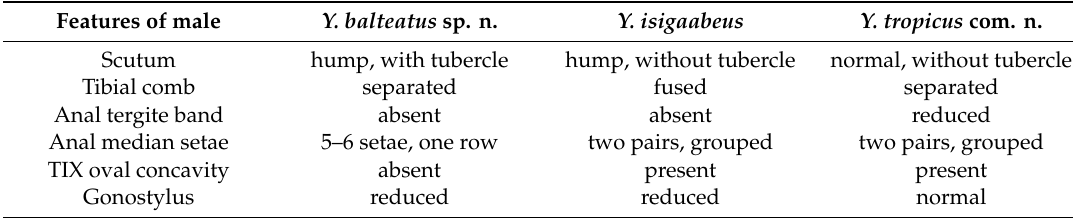
Table 1. The main morphological di ff erences on male adults of three Yaeprimus species. Features of male hump, with tubercle hump, without tubercle Tibial comb separated fused separated Anal tergite band absent absent reduced Anal median